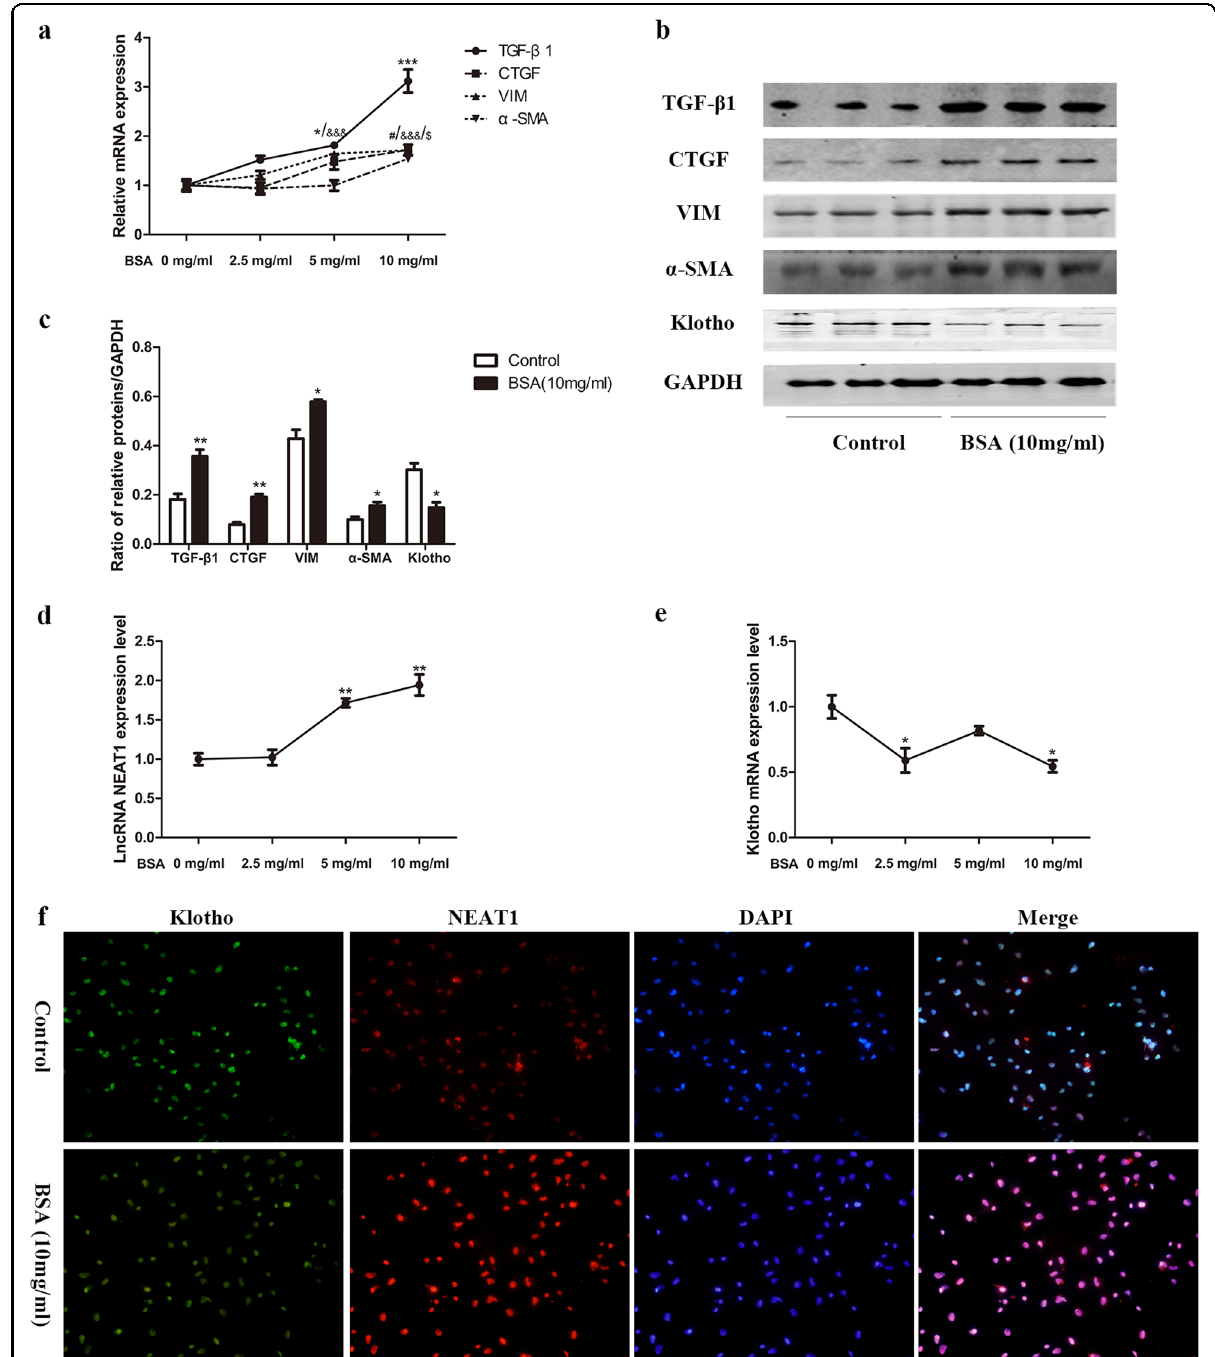
Fig. 3 Bovine serum albumin (BSA) upregulated NEAT1 expression in HK-2 cells. HK-2 cells were cultured in different concentrations of BSA. a The relative mRNA expression of TGF- β 1, CTGF, vimentin and α -SMA in HK-2 cells after incubation with various concentrations of BSA was measured by qRT-PCR. TGF- β 1 (* p < 0.05 vs 0 mg/ml, ** p < 0.01 vs 0 mg/ml, *** p < 0.001 vs 0 mg/ml); CTGF ( # p < 0.05 vs 0 mg/ml, ## p < 0.01 vs 0 mg/ ml, ### p < 0.001 vs 0 mg/ml); vimentin ( & p < 0.05 vs 0 mg/ml, && p < 0.01 vs 0 mg/ml, &&& p < 0.001 vs 0 mg/ml); α -SMA ( $ p < 0.05 vs 0 mg/ml, $$ p < 0.01 vs 0 mg/ml, $$$ p < 0.001 vs 0 mg/ml). b , c The relative protein expression of TGF- β 1, CTGF, vimentin, α -SMA, and Klotho in HK-2 cells after incubation with 10 mg/ml BSA was measured by western blots. d Relative mRNA expression of Klotho in HK-2 cells after incubation with 10 mg/ml BSA was measured by qRT-PCR. e Levels of lncRNA NEAT1 in HK-2 cells after incubation with 10 mg/ml BSA by qRT-PCR. f Immuno fl uorescence and fl uorescence in situ hybridization (FISH) were performed to investigate Klotho colocalization with NEAT1 in 10 mg/ml BSA-treated HK-2 cells. * p < 0.05 vs control, ** p < 0.01 vs control, *** p < 0.001 vs